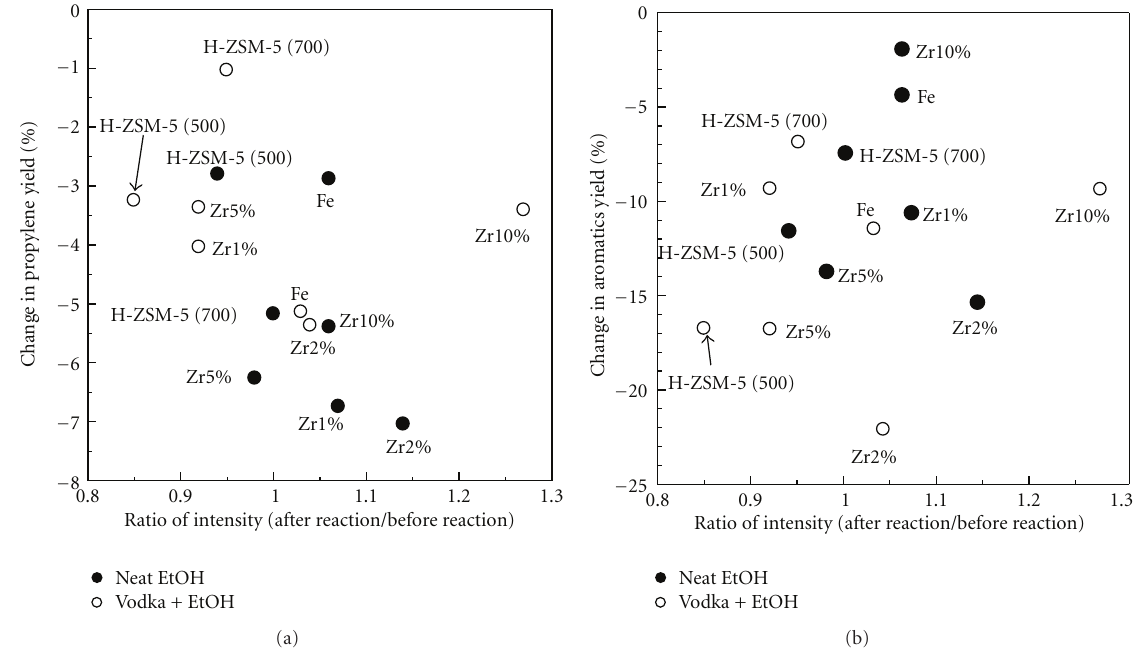
Figure 3: Plots of the ratio of XRD peak intensity at 23.1 ◦ (after reaction/before reaction) versus the change in product yield over H-ZSM-5 and (Fe or Zr)/H-ZSM-5 catalysts. (a) Propylene yield and (b) aromatics yield.